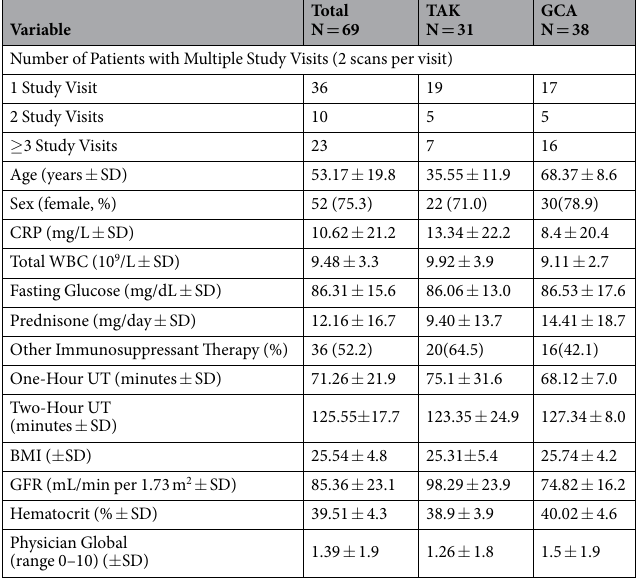
Table 1. Study Population Baseline Characteristics. GCA, giant cell arteritis; TAK, Takayasu’s arteritis; CRP, C-Reactive Protein; Total WBC, Total White Blood Cell Count; UT, uptake time; BMI, Body Mass Index; GFR, Glomerular Filtration Rate. Age, CRP, Total WBC, Fasting Glucose, Prednisone, One-hour and Two-hour Image Acquisition Time, BMI, GFR, Hematocrit, and Physician Global are all reported as mean ± standard deviation. Sex and Other Immunosuppressant Therapy are reported as number of individuals